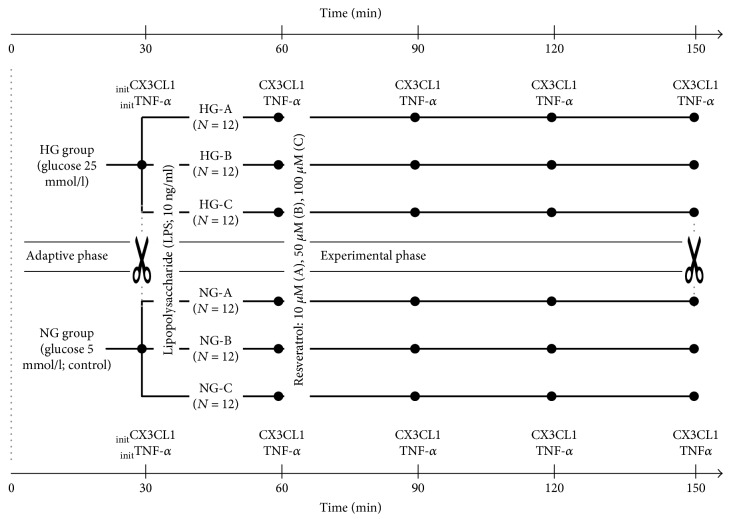
The experimental setup of the perfusion procedures with measurement time points for CX3CL1 and TNF-α (marked with dots). The initial concentrations of CX3CL1 and TNF-α were measured at the end of adaptive phase (initCX3CL1 and initTNF-α, resp.). Time points for the collection of the placental specimens are marked with scissors icon.